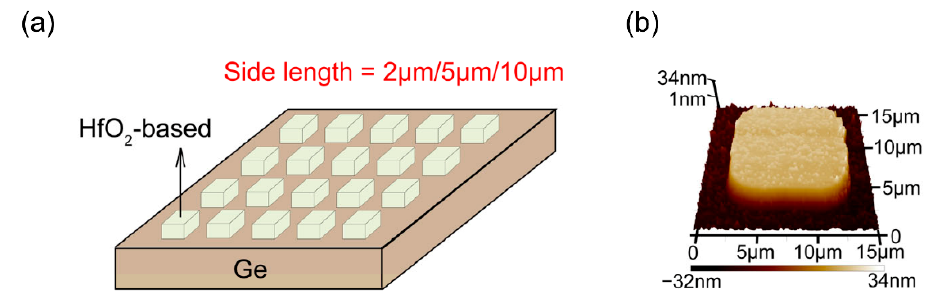
Figure 4. ( a ) Graphical presentation of cuboid array films whose side lengths were set to 2 μ m, 5 μ m, and 10 μ m before PDA. ( b ) AFM diagram of one cuboid in a 10 μ m array, showing that HfO 2 -based films were all etched.